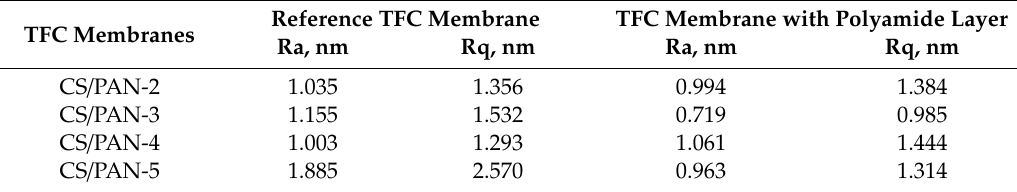
Table4. CS-basedmembraneroughnesscharacteristics. Themeanaccuracyforroughnesscharacteristics was < ±